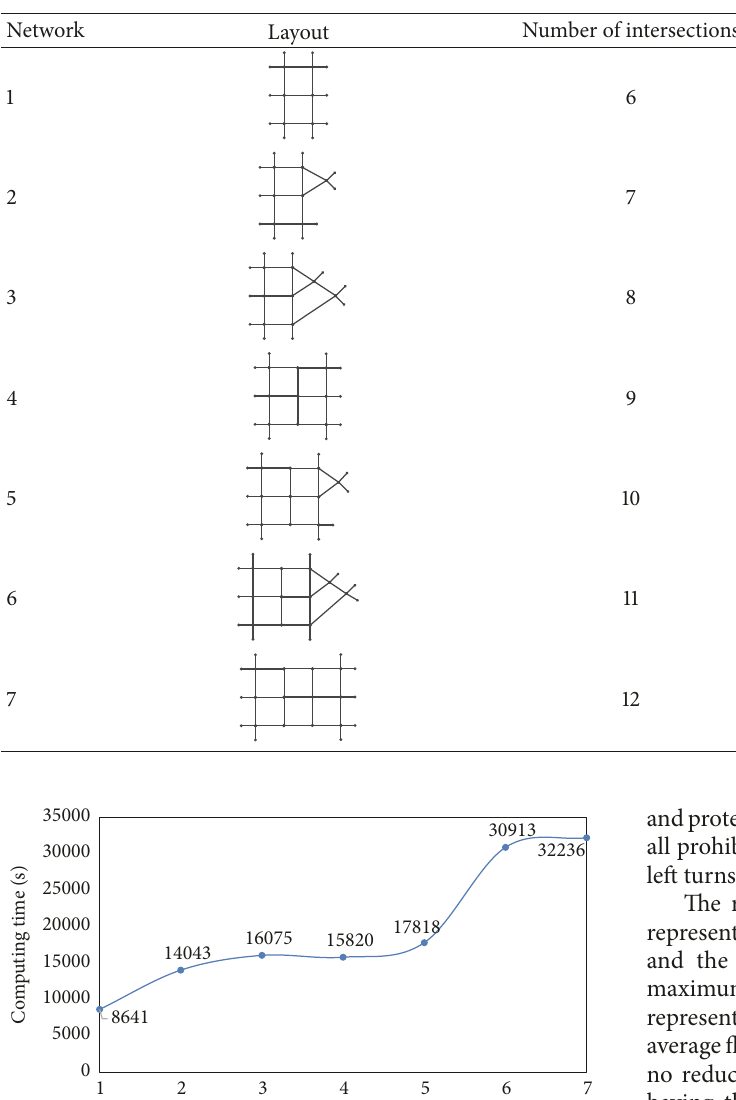
Table 4: Network scale information for algorithm evaluation.